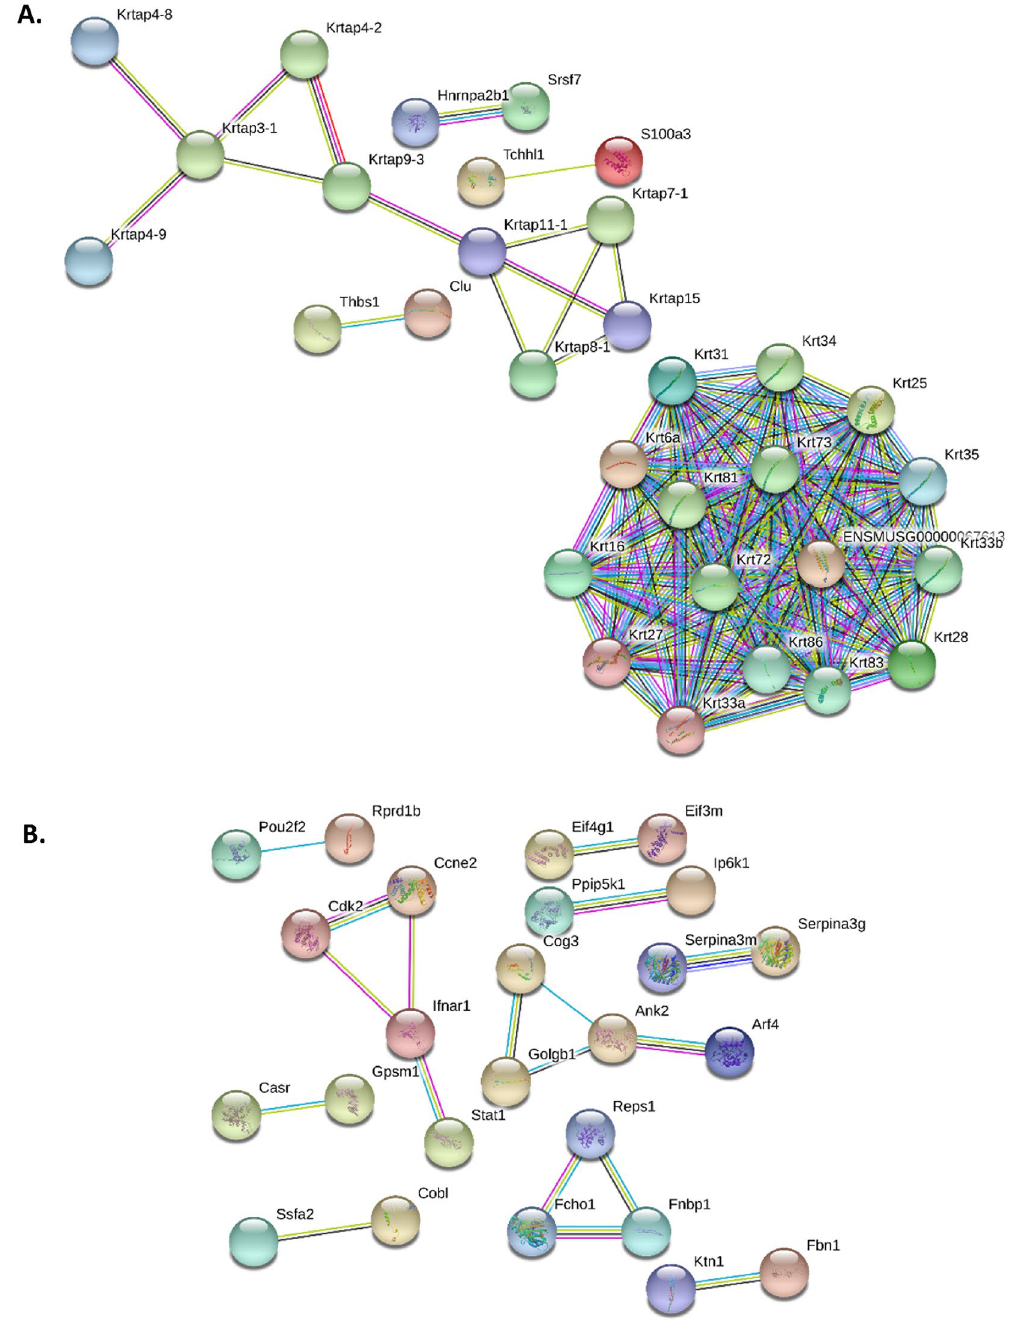
Figure 4. Protein–protein interaction of mouse skin genes regulated 3 months after ( A ) PBS or ( B ) DS irradiation (STRING